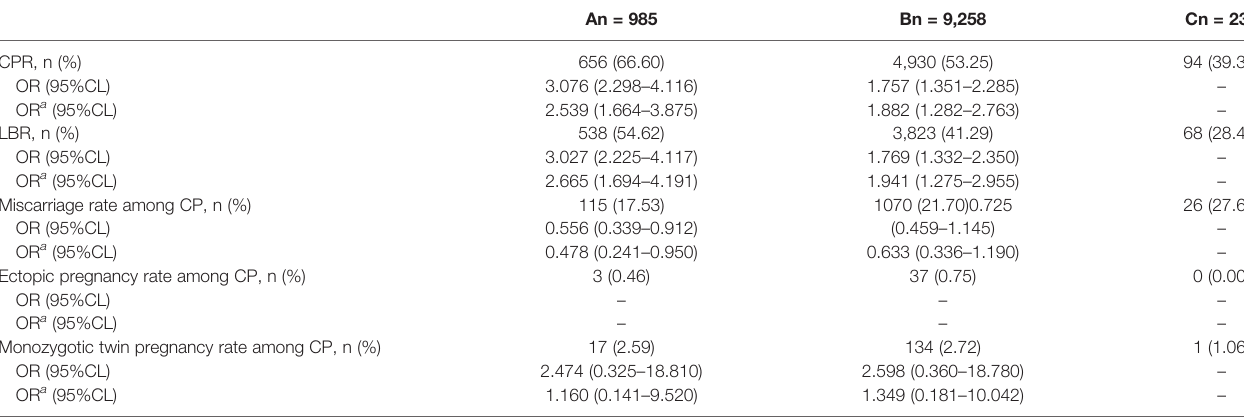
TABLE 3 | Pregnancy outcomes according to the ICM grade.